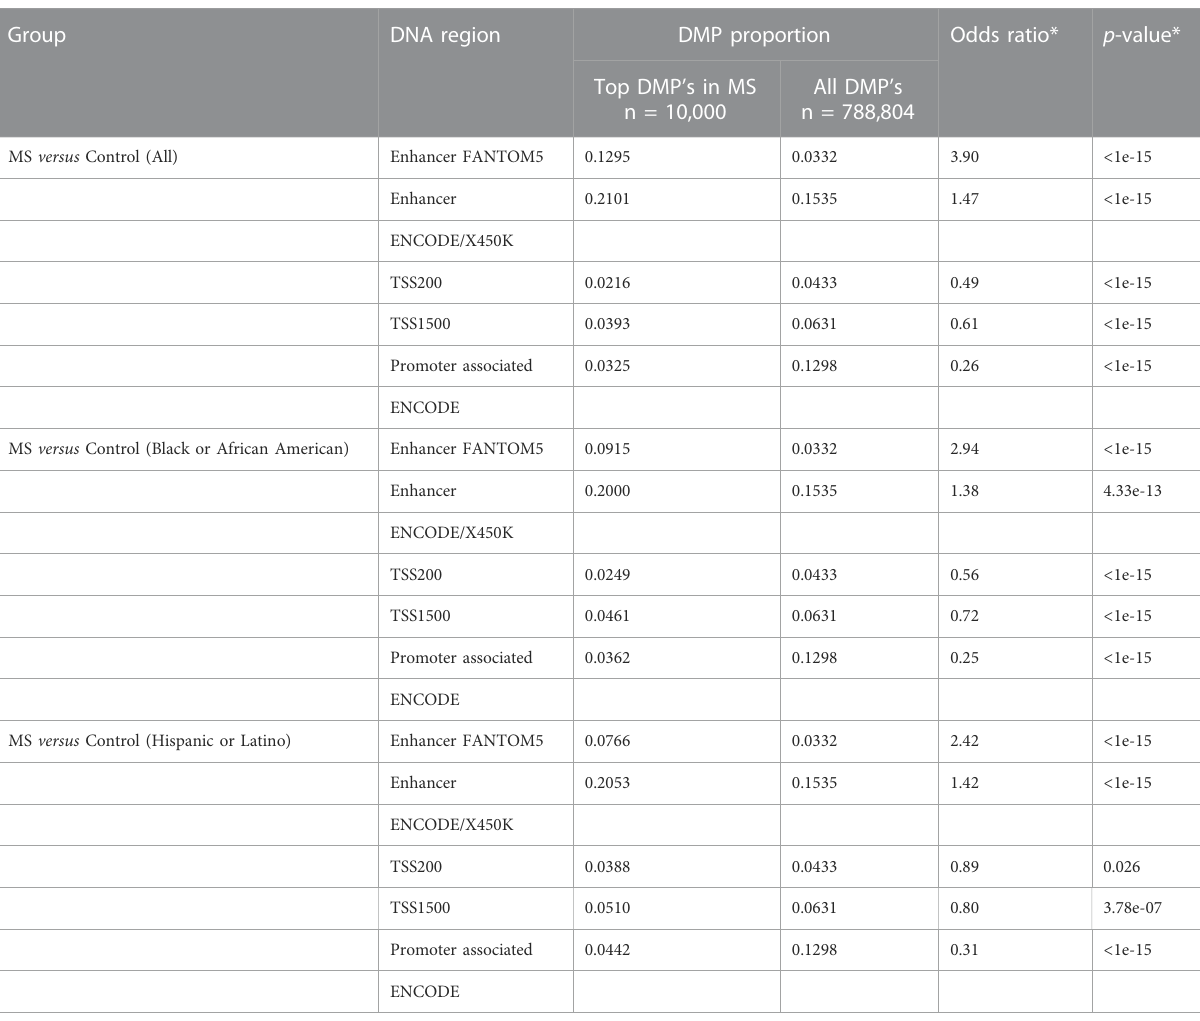
TABLE 4 Enrichment analysis for DNA regulatory regions.